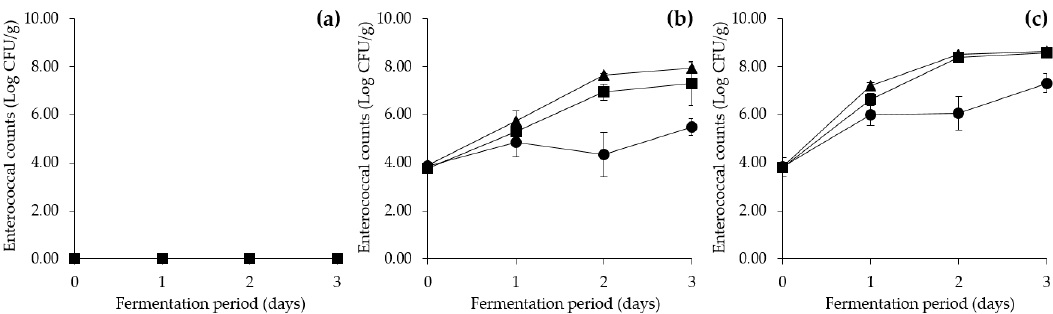
Figure 4. Effect of fermentation temperature on enterococcal counts in Cheonggukjang inoculated with ( a ) B. subtilis KCTC 3135, ( b ) B. subtilis KCTC 3135 and E. faecium KCCM 12118, and ( c ) B.